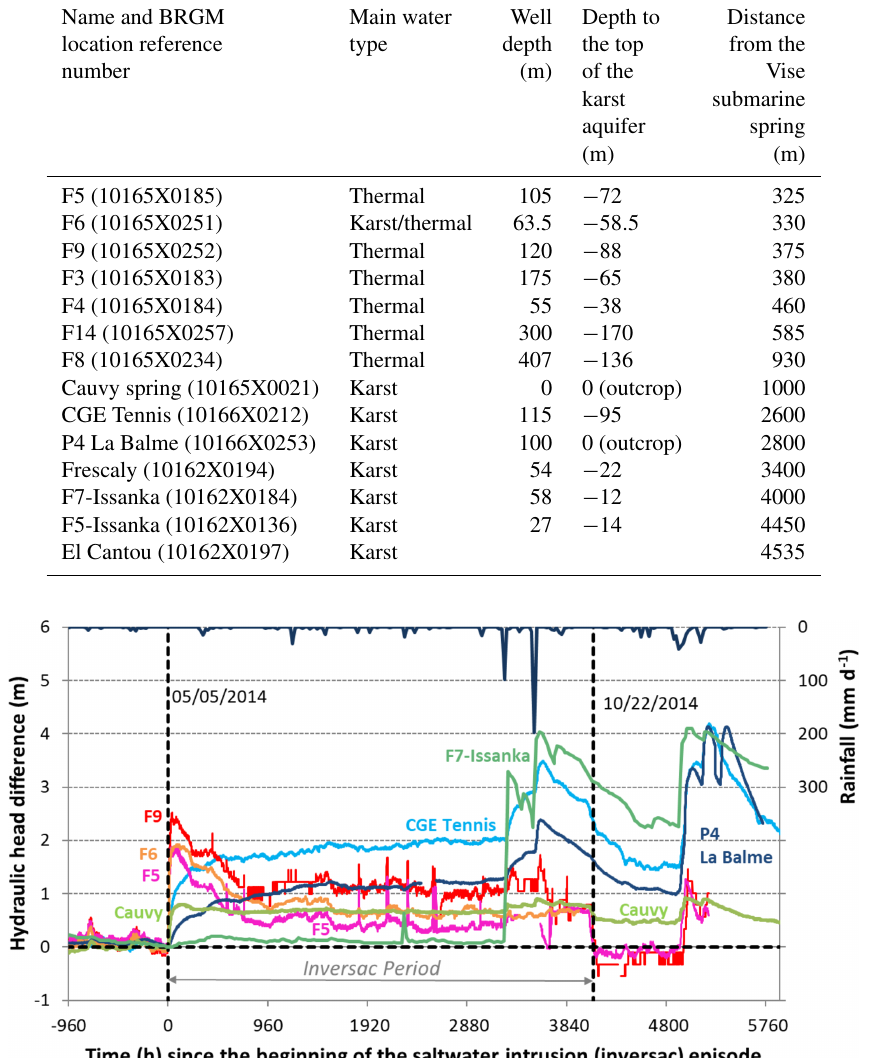
Figure 3. Evolution of variations in hydraulic heads (m) of wells and springs across the study area during the 2014 inversac event. The rainfall record during this time is shown at the top of the